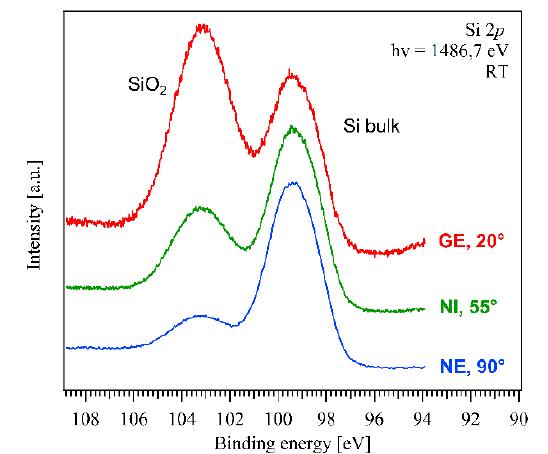
Figure 1. XPS Si 2p spectra taken at different electron emission angles from normal (90°) to grazing (~20°).